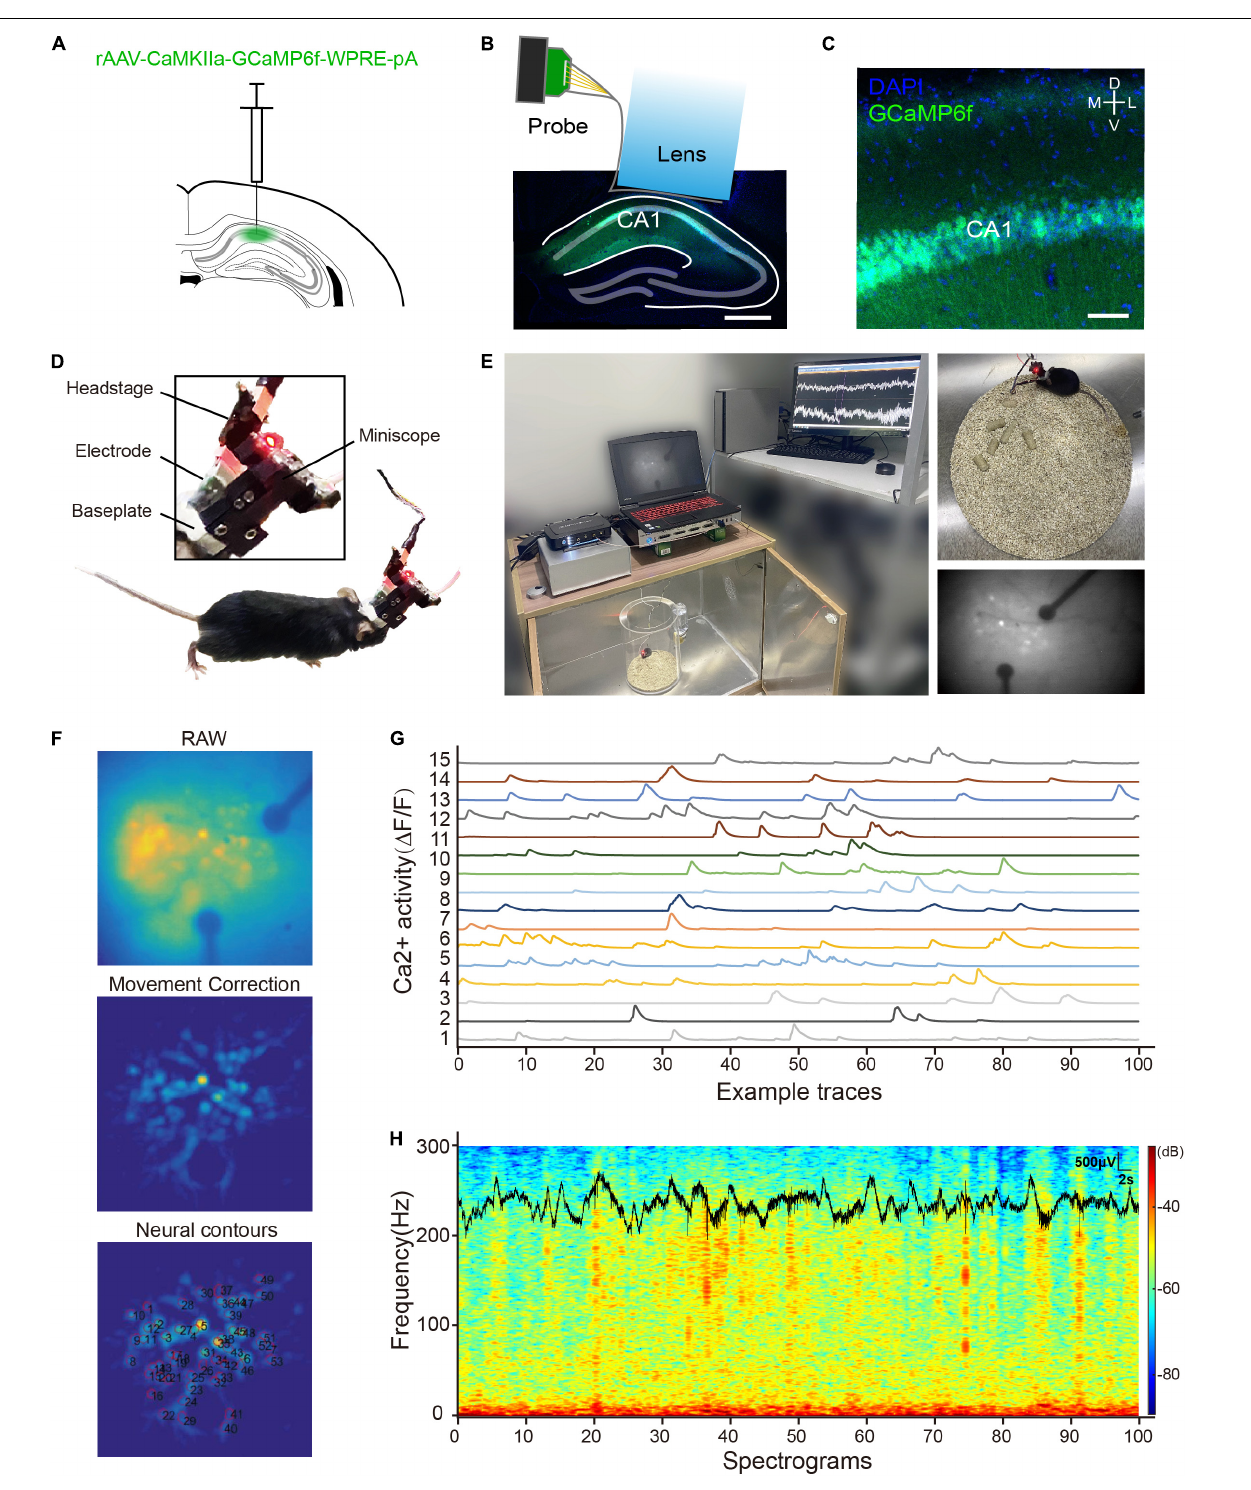
FIGURE 4 | (A) A picture of virus injection; (B) an image of CA1 region with an assembled electrode probe and GRIN lens implant. Scale bar, 500 µ m; (C) confocal image of rAAV-CaMKIIa-GCaMP6f-WPRE-pA expression in the CA1 region, GCaMP6f (green), and 4 (cid:48) ,6-diamidino-2-phenylindole (DAPI) (blue). Scale bar, 50 µ m; (D) profile display of electrophysiology and calcium imaging head-fixed interface; (E) calcium imaging and local field potential (LFP) recording in mouse CA1 region with an assembled probe and GRIN lens; (F) key processing steps of MIN1PIPE-master; (G) the traces of spontaneous Ca 2 + activity from 15 CA1 neurons identified by the MIN1PIPE-master program; and (H) the example traces of synchronous LFP and power spectrograms in the CA1 region.